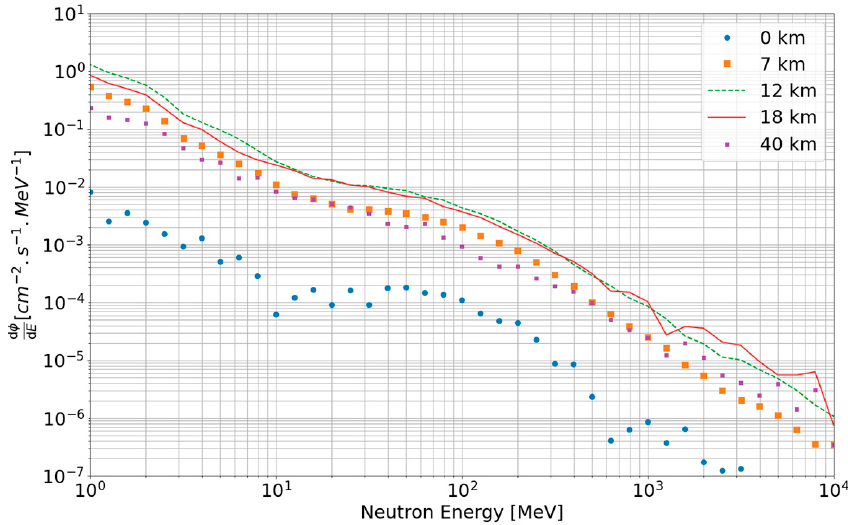
Figure 13. Flux of neutrons given by RAMSEES at different altitudes.